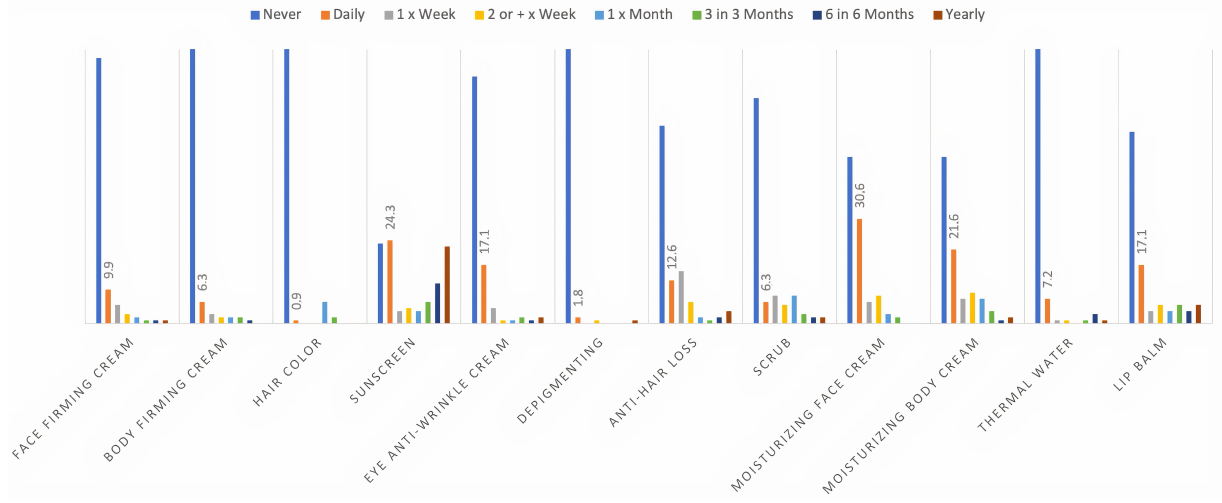
Fig. 2. Type and frequency of use (%) of cosmetic products by male